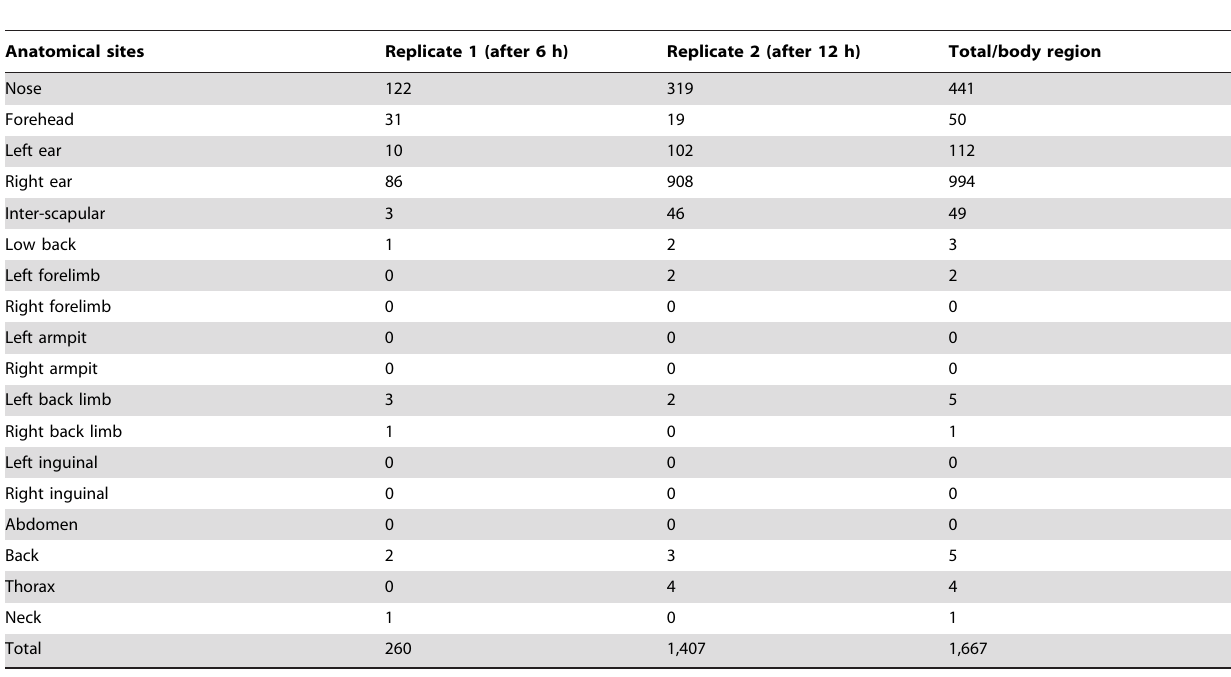
Table 1. Number of O. lupi microfilariae retrieved by soaking skin samples from each anatomical site collected at the necropsy of dog 1.